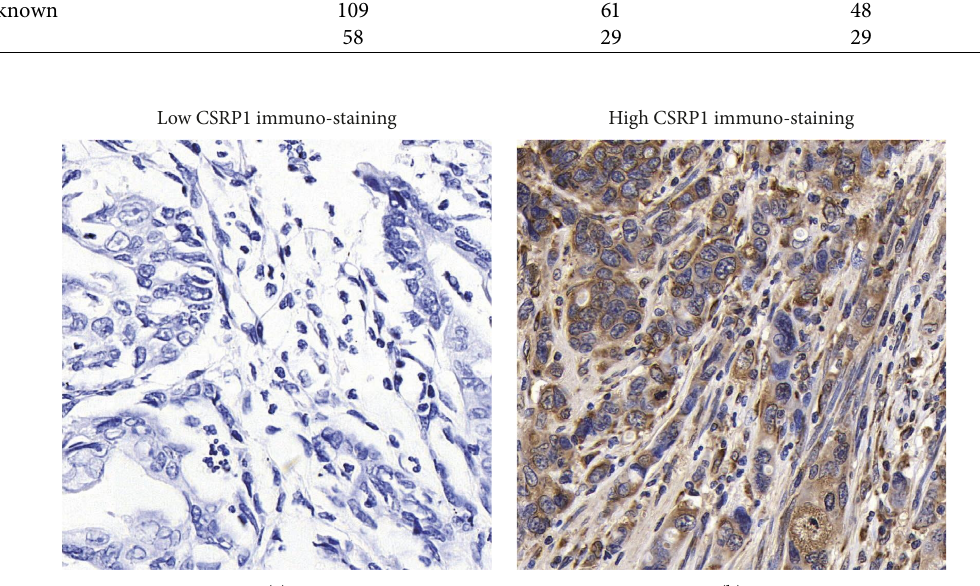
Figure 2: Protein expression of CSRP1 in COAD tissues. Representative IHC staining results of low-CSRP1 protein expression (a) and high- CSRP1 protein expression (b) images. Magnifcation: 400 ×